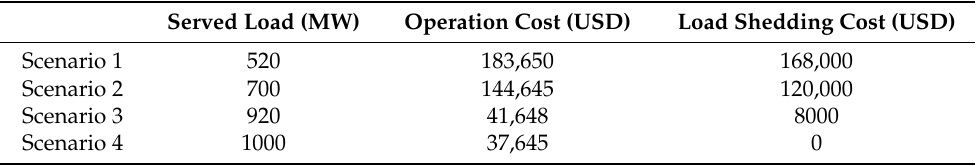
Table 13. Scenario results according to costs served